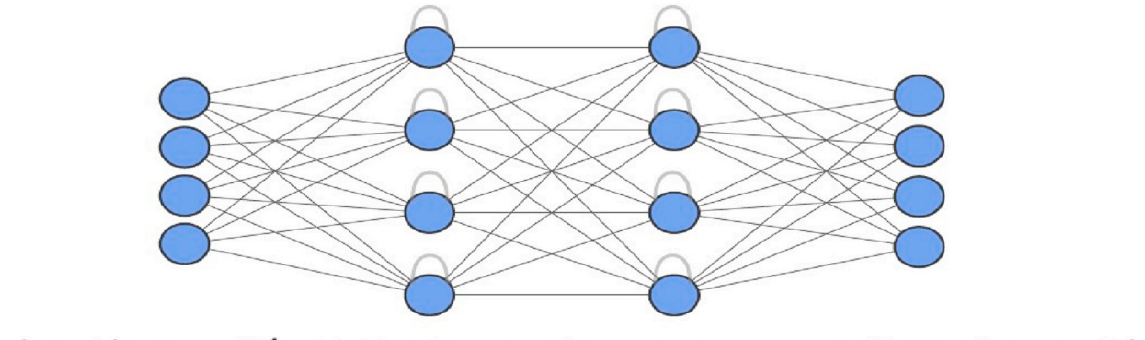
Figure 3. Recurrent neural networks (RNNs) architecture . Reproduced with permission from ref. [26]. Copyright 2020 Elsevier.